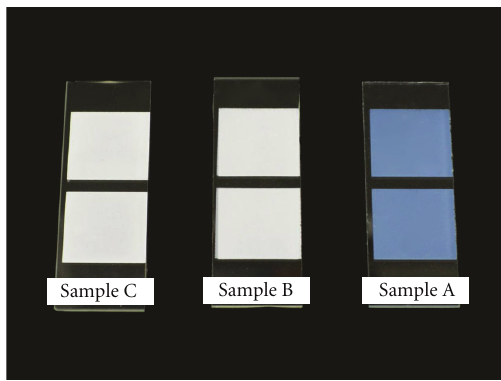
Figure 5: Optical photograph showing the appearance of 4 μ m thick TiO 2 -coated